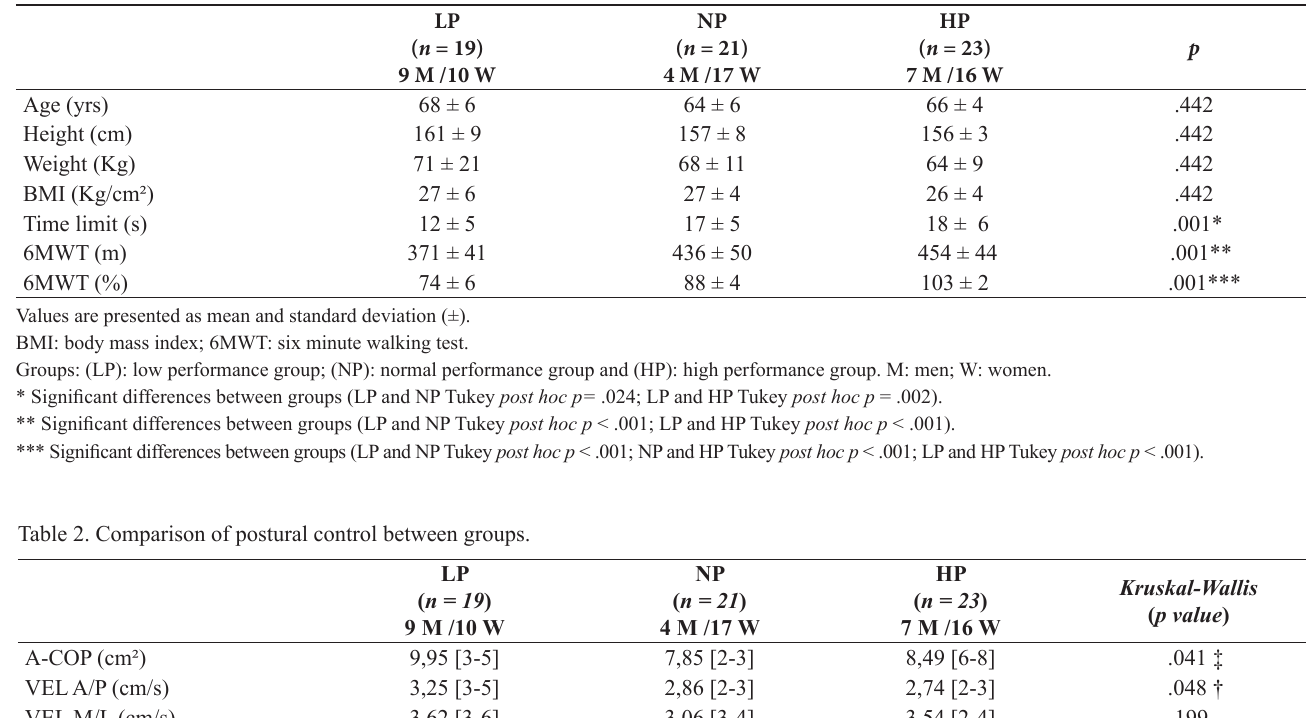
Table 1. Results of characteristics of participants and tests